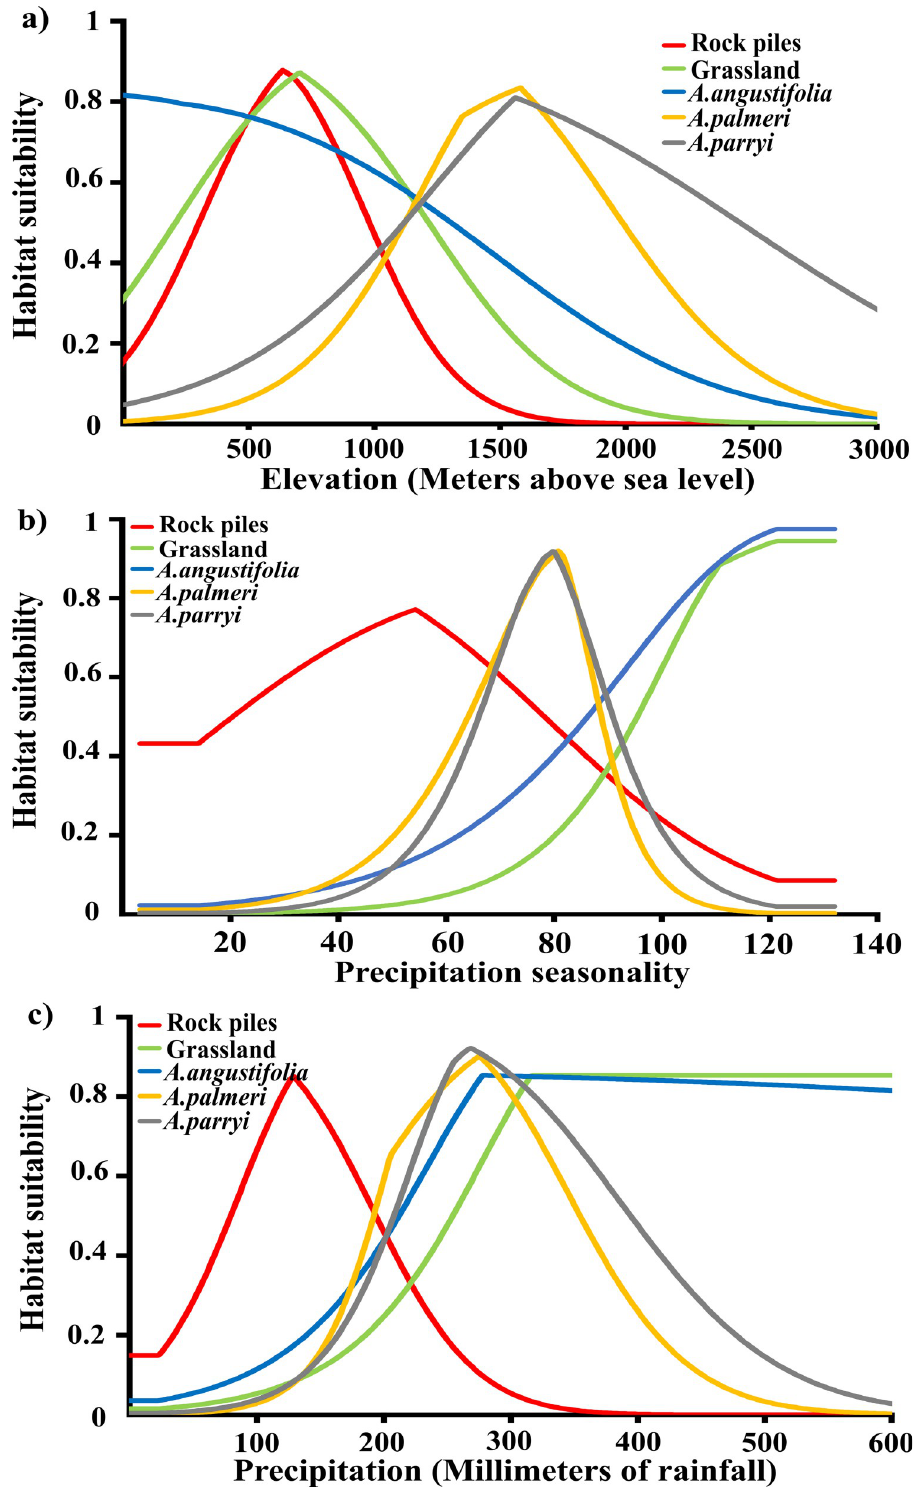
Fig 4. Habitat suitability for rock piles, grasslands, and Agave species ( A . angustifolia , A . palmeri , and A . parryi) during the wettest season in a given year in terms of three environmental variables: (a) elevation, (b) precipitation seasonality, and (c) annual